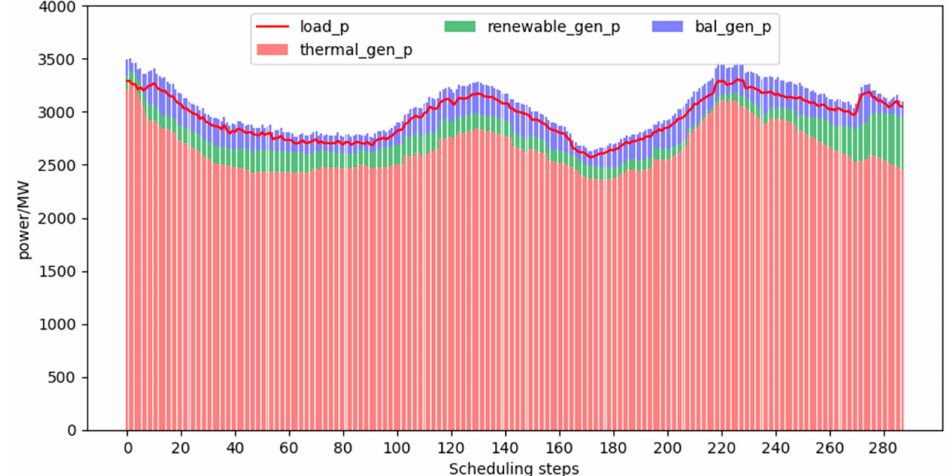
Figure 3. The scheduling period in which the total load is